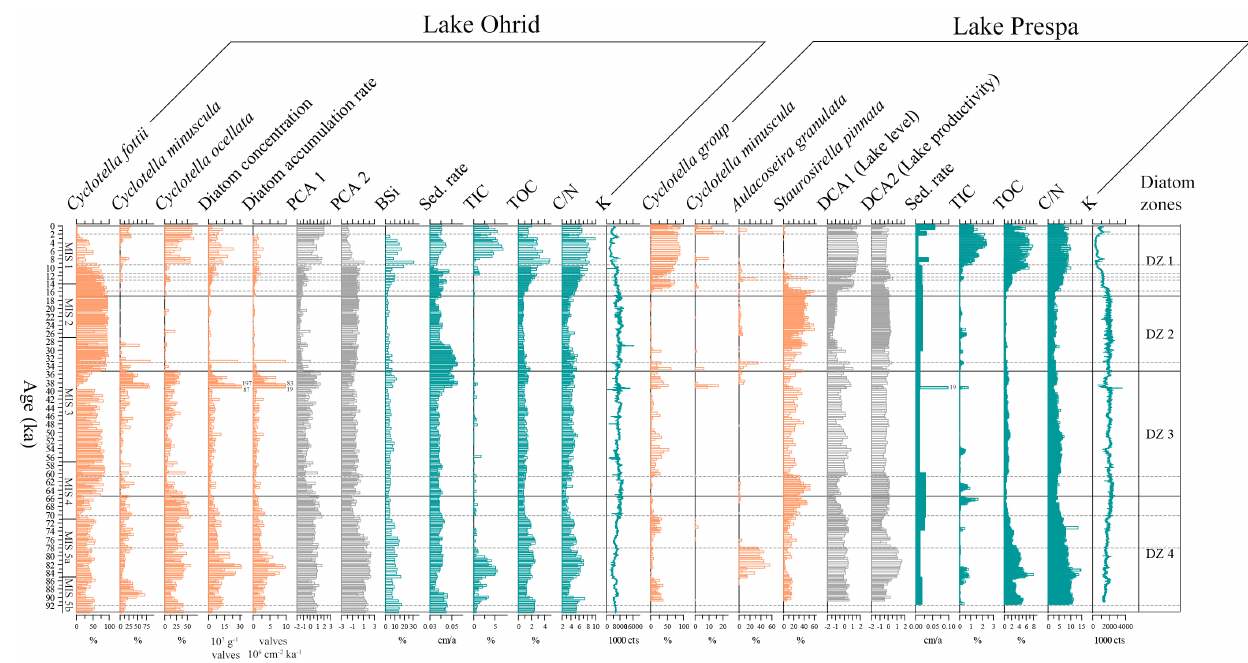
Figure 4. Comparison diagram between Lake Ohrid core 5045-1 and Lake Prespa core Co1215 showing the relative abundance data of selected diatom species, the PCA 1 and 2 sample scores; DC and DAR, the sediment accumulation rates (SAR) and the biogenic silica content (BSi, % weight) of Lake Ohrid core DEEP. Prespa DCA 1 and 2 sample scores represent lake level and productivity. Displayed are the diatom zones (DZ 1–4) of Lake Ohrid core DEEP; the dotted lines mark the six major diatom zones of Lake Prespa core Co1215 (Cvetkoska et al., 2015). Selected geochemical proxies from Lake Ohrid core DEEP: total organic carbon (TOC), total inorganic carbon (TIC), C / N ratio and potassium (K); data from Francke et al. (2016); Lake Prespa core Co1215: TOC, TIC, C / N ratio, K; data from Wagner et al. (2012) and S. pinnata (%), data from Cvetkoska et al. (2015). The MIS boundaries are from Lisiecki and Raymo (2005). Table 3. Spearman’s rho ( q ) coefficient values for the correlations between selected diatom data, and geochemical proxies from Lake Ohrid DEEP site core. Spearman’s correlation Cyclotella DC DAR